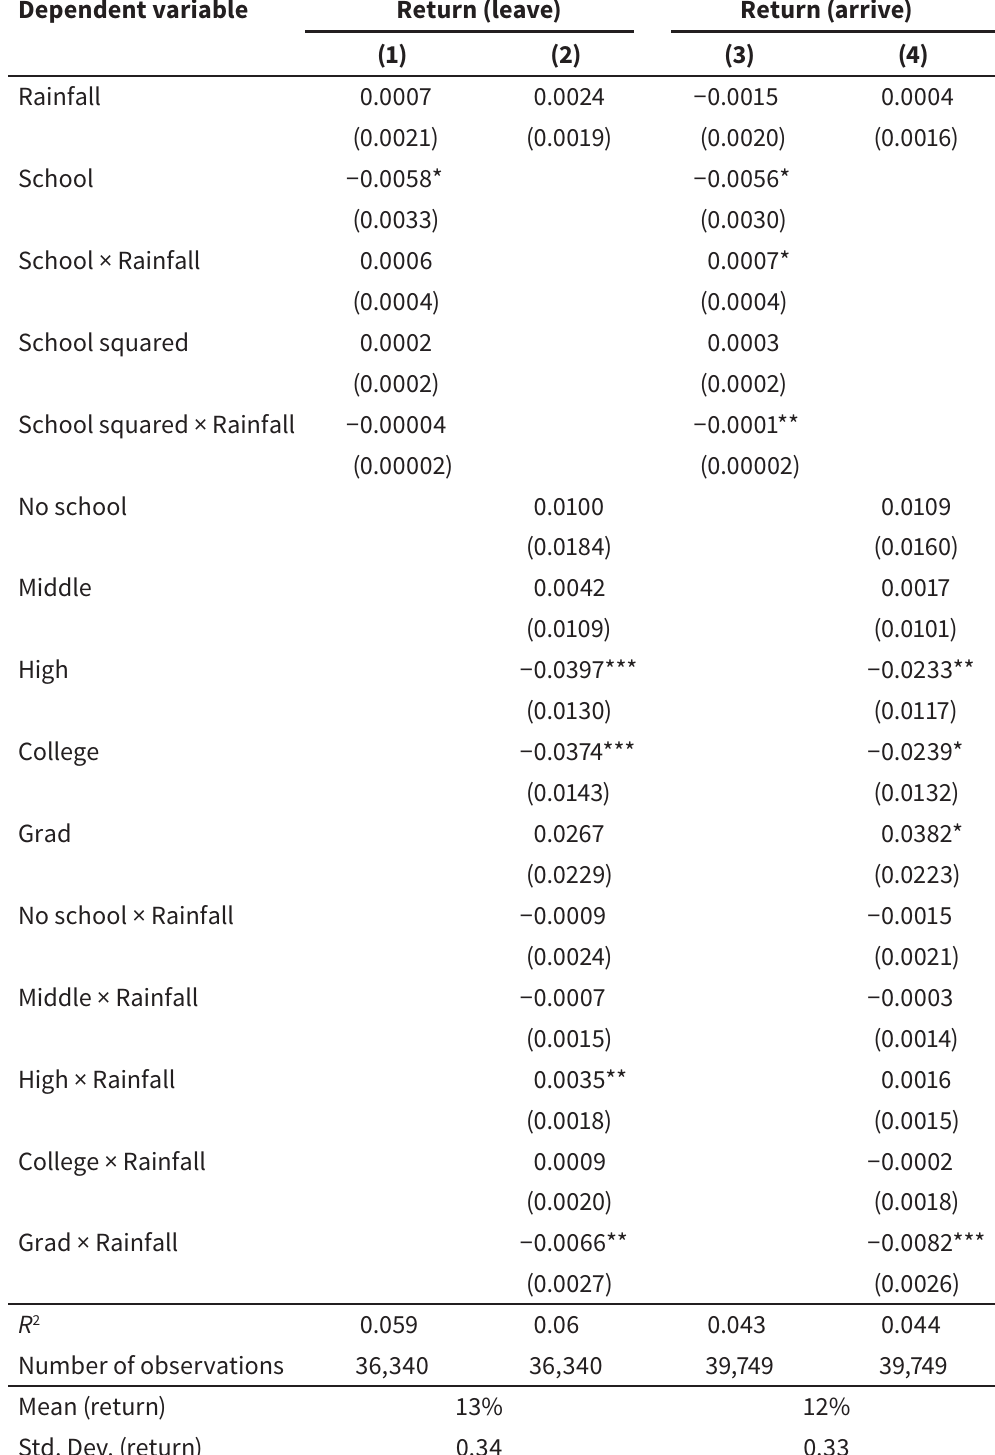
Return decision varies with rainfall by schooling (selected